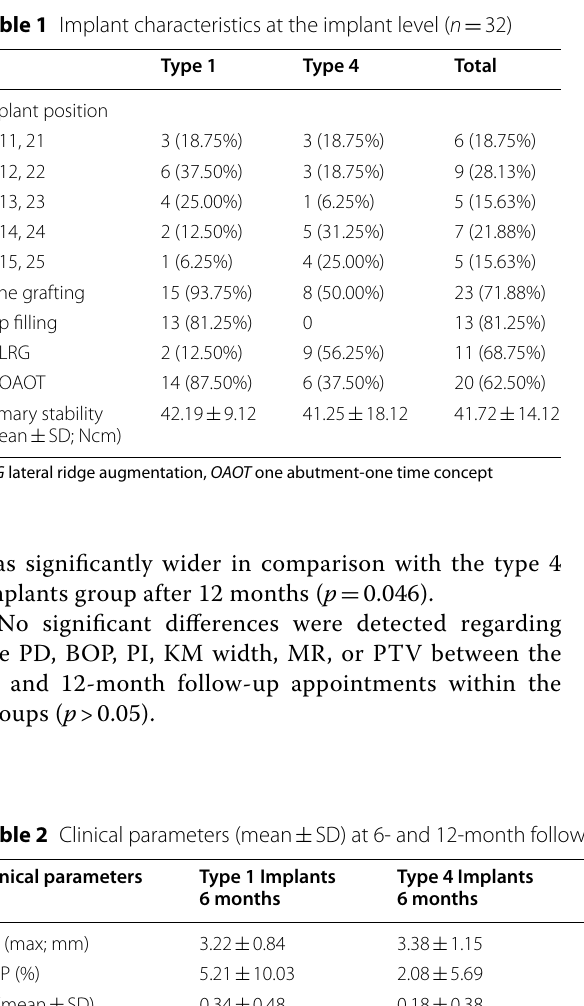
KM width (buccal; mm)